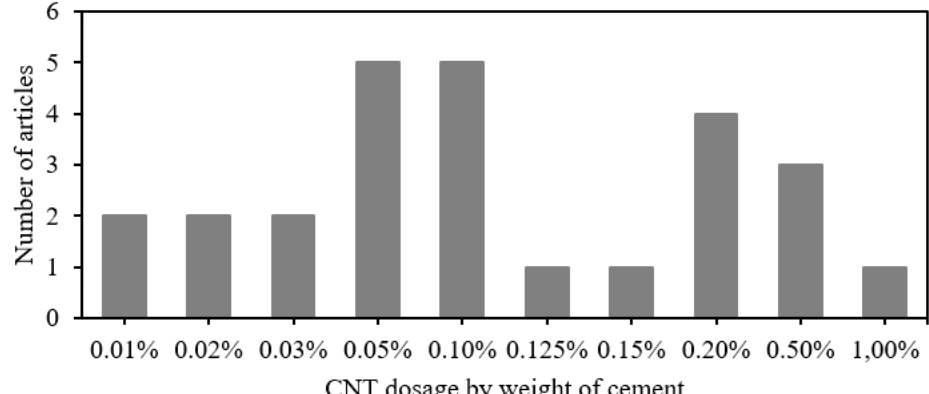
Figure 2. Frequency of each CNT dosage in the selected bibliography.